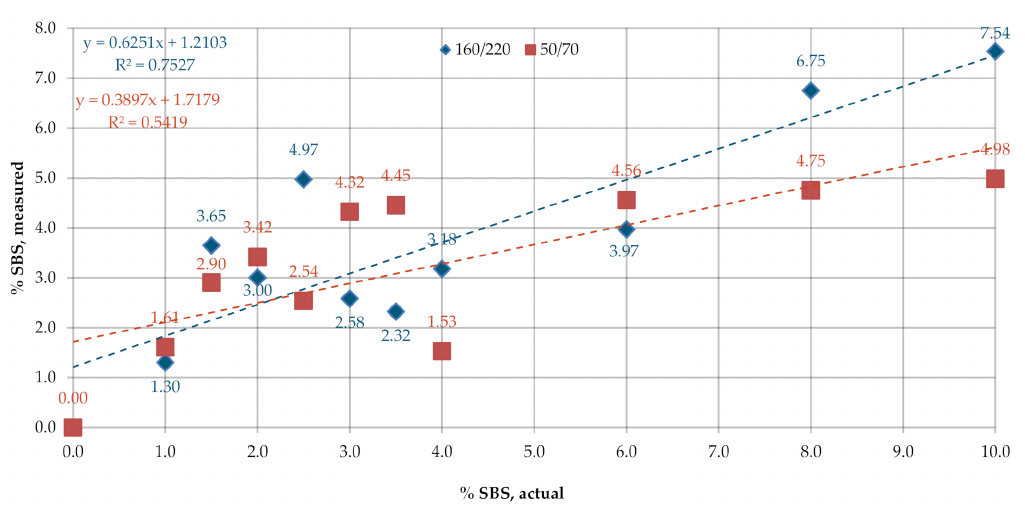
Figure 15. SBS contents in the samples of bitumens 160 / 220 and 50 / 70.